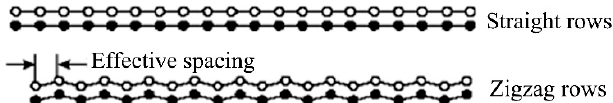
Figure 9. Schematic illustration of the interface formed through the edge-to-edge matching manner, reproduced from Reference [66], with permission of Elsevier, 2009.